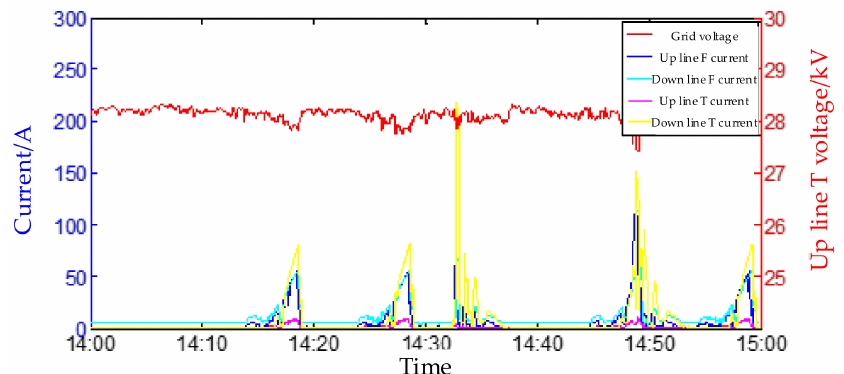
Figure 14. Ground currents and induced voltages at the substation of “Hukun